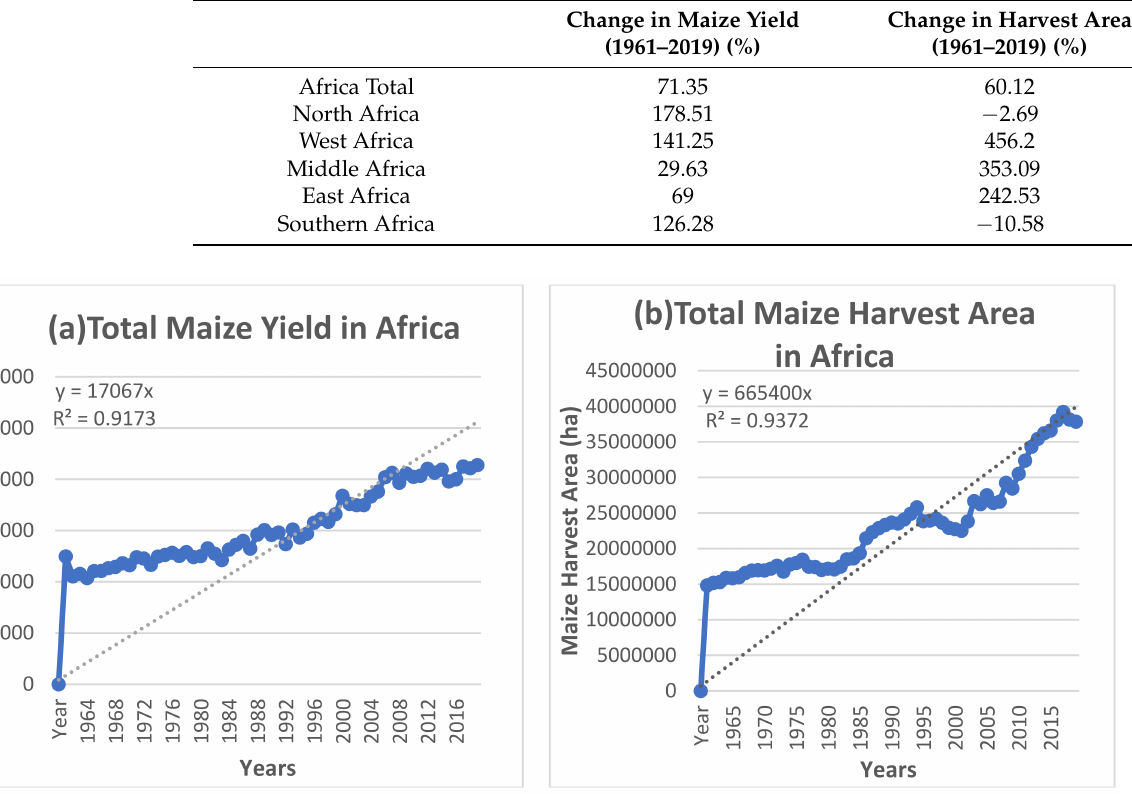
Table 2. Change in maize yield and harvest area from 1961 to 2019 across Africa.